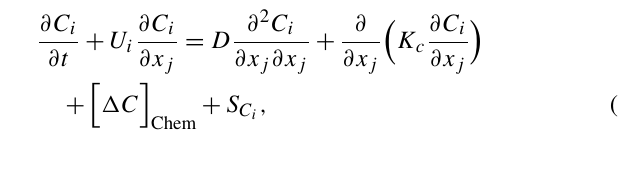
Table 1. The complex chemical mechanism (CCM-CFD): the units of the rate constants of first-order reactions are s − 1 and of second-order reactions cm 3 s − 1 . The rate constants for the reactions called “thermal” can be calculated by k = A · exp [ ( − E/R)/T ] , of reactions called “Troe” by k = { k 0 (T ) [ M ] )/( 1 + (k 0 (T ) [ M ] /k ∞ (T )) } 0 . 6 { 1 +[ log 10 (k 0 (T) [ M ] /k ∞ (T)) ] 2 } A exp ( − B/T ) ×{ k 0 (T ) [ M ] /( 1 + (k 0 (T ) [ M ] /k ∞ (T ))) } 0 . 6 { 1 + log 10 [ k 0 (T) [ M ] /k ∞ (T) ] 2 } k ∞ 300 (T/ 300 ) − m